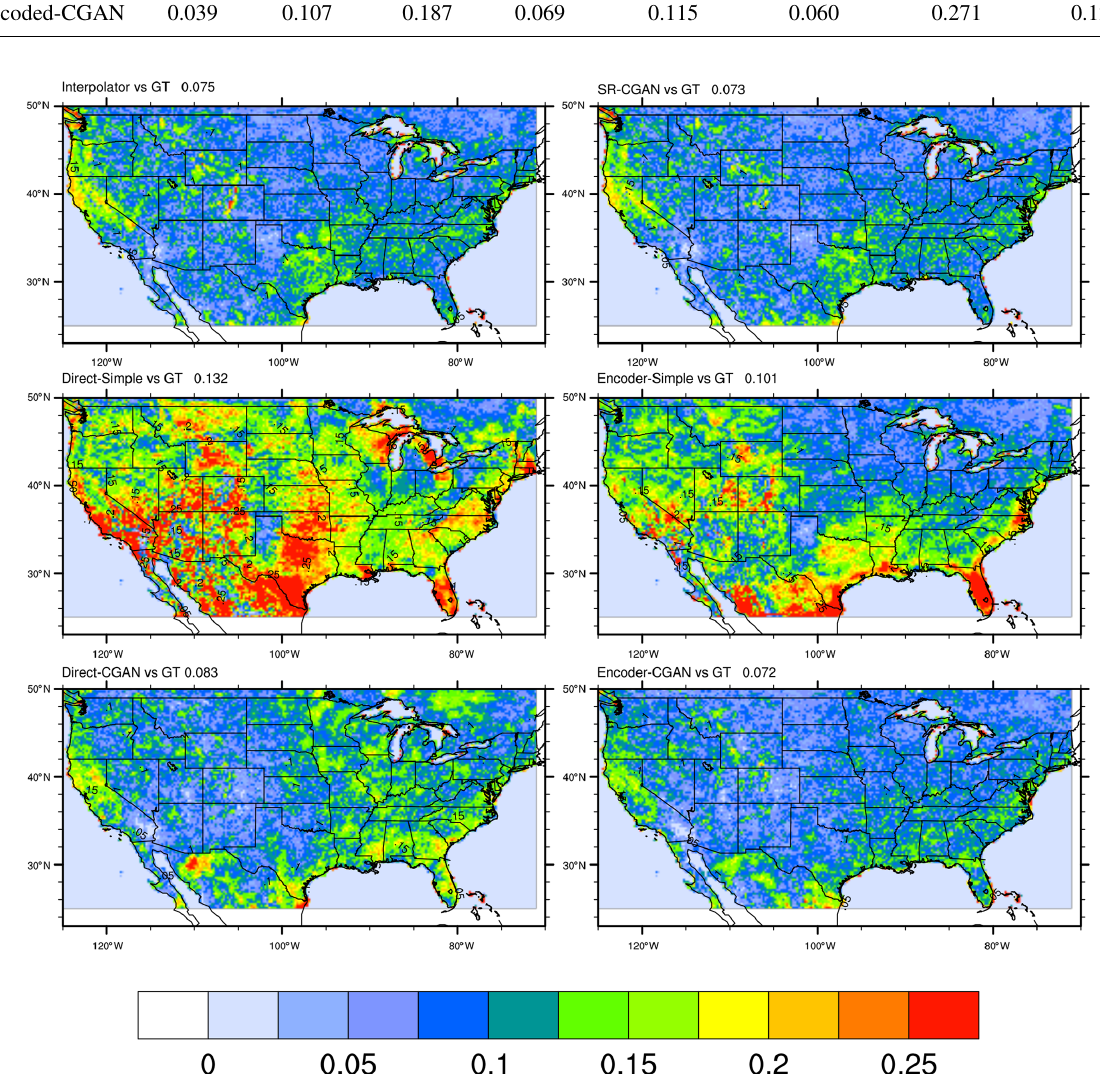
Figure 7. J–S distance (Eq. 3) measuring the similarity of the PDFs between Ground Truth and six predictive models for the testing period